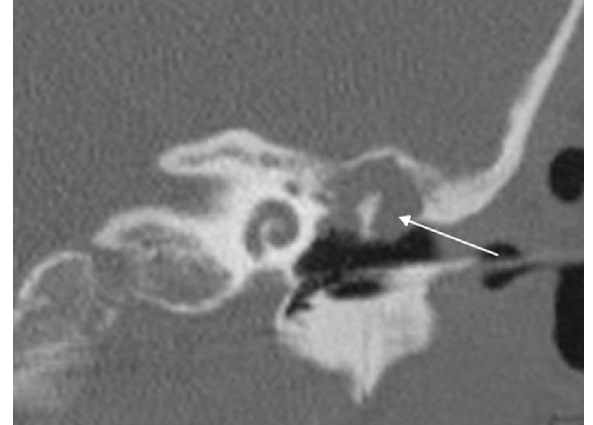
Sagittal MDCT scan of the left temporal bone at the level of malleus handle, showing the soft tissue mass in the attic